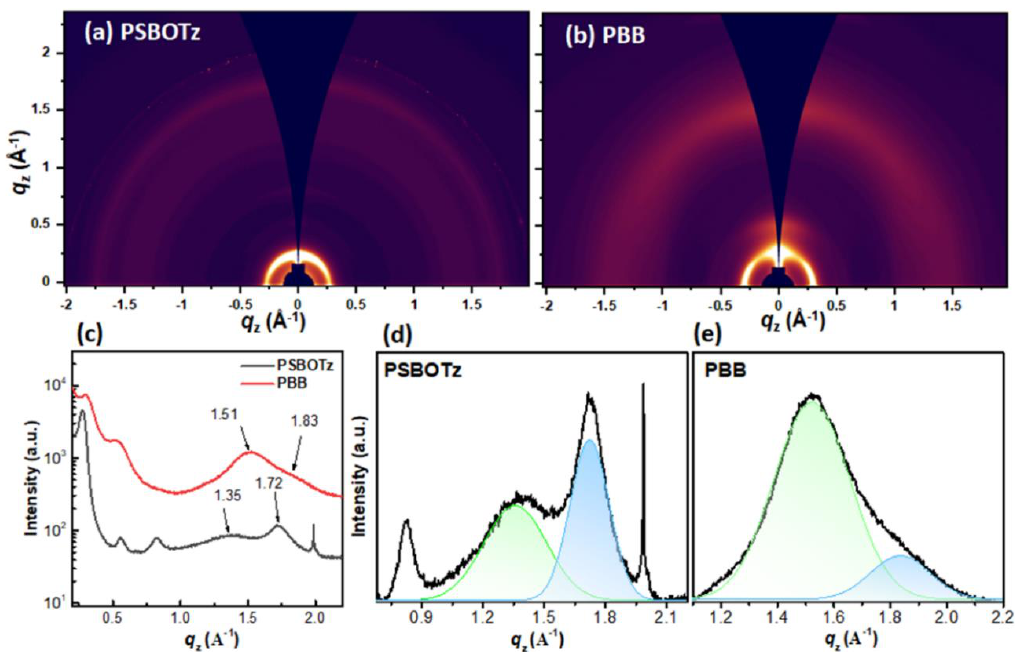
Figure 5. Two-dimensional GIWAXS plots of ( a ) pristine PSBOTz and ( b ) PBB films. ( c ) Line-cut profile of pristine PSBOTz and PBB films along the q z axis. Deconvoluted line-cut profile of (d) pristine PSBOTz and ( e ) pristine PBB films shown in Figure 5c.